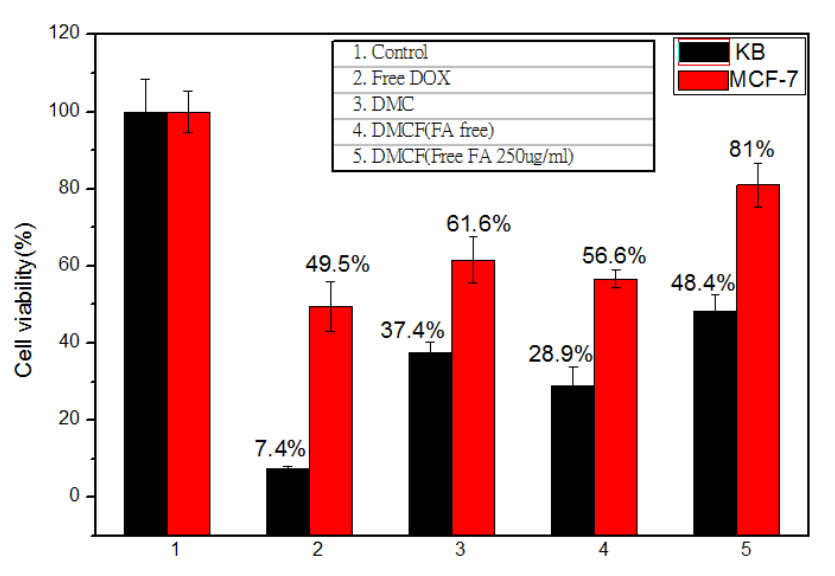
Figure 3. Effect of free FA on the cell viabilities of MCF-7 and KB cells incubated with various DOX formulations for 24 h (DOX concentration: 10